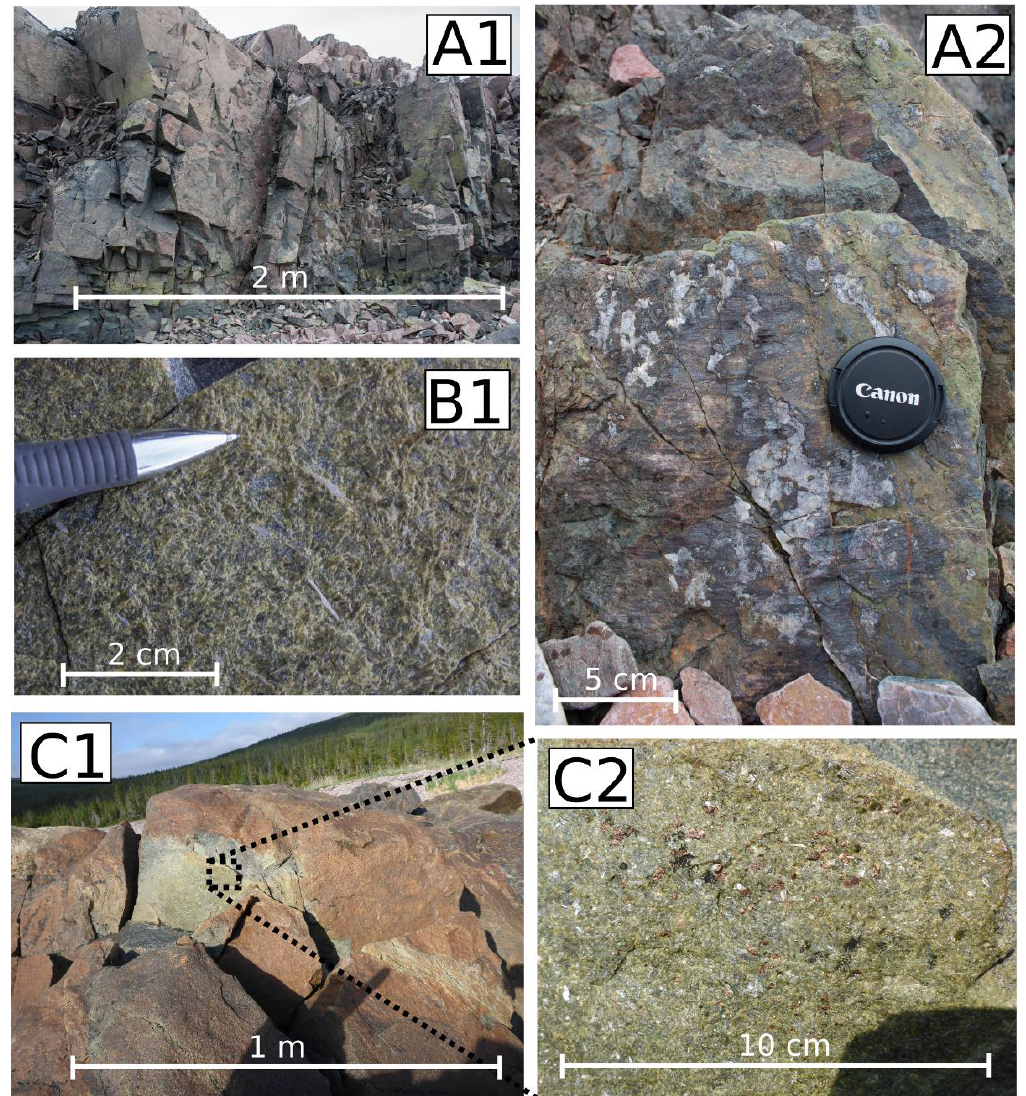
Figure 10. Examples of the variability in occurrences of the widespread brittle deformation event associated with epidote mineralisation modelled in this study as inversion B. Subfigure ( A1 ) is located on Big Island (Figure 1) where abundant epidote mineralisation often associated with slicken lines, such as those in ( A2 ), was observed to be widespread. The outcrop in subfigure ( B1 ) was observed on Makkovik Peninsula and shows an example of a mineralised surface in which no kinematic indicators are present. Surfaces such as those in ( B1 ) potentially represent mode I fractures. Subfigures ( C1 ) and ( C2 ) show an outcrop of mafic dyke in Fords Bight containing pyrite and epidote.